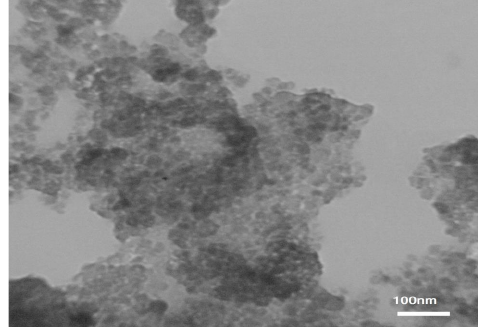
O @PEO-SO H nanocatalyst 2 4 3 with scale of 100 nm. Fig. 6. VSM magnetization curves of CuFe